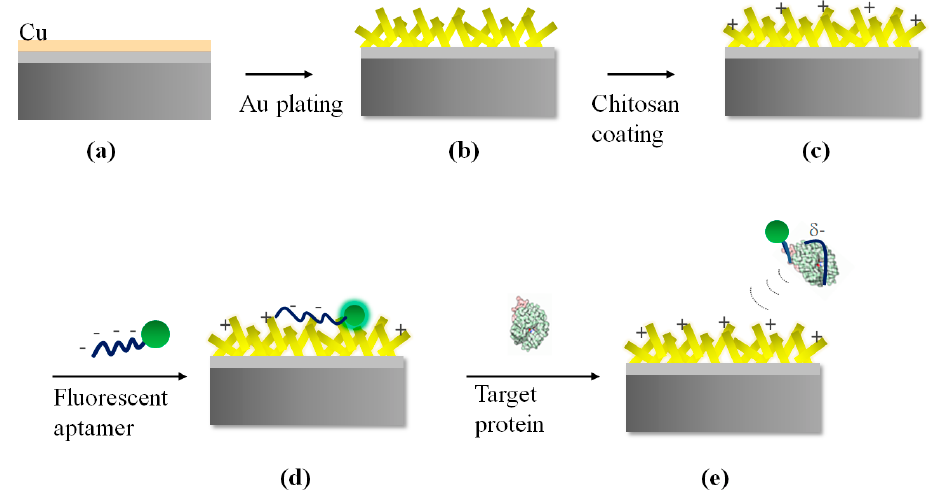
Figure 1. Schematic of aptamer-based fluorescence assay on fabricated Au nanostructures. ( a ) Cu deposited by e-beam evaporation; ( b ) Au nanostructures fabricated through electroless plating; ( c ) Chitosan-coated Au nanostructures; ( d ) Binding of fluorescent DNA to Au nanostructures; ( e ) specific aptamer–target binding leaving behind the chitosan-coated Au